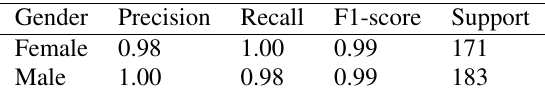
Figure 7. 2-dimensional PCA scatter plot for Emotion Table 1. Evaluation metrics for gender recognition Gender